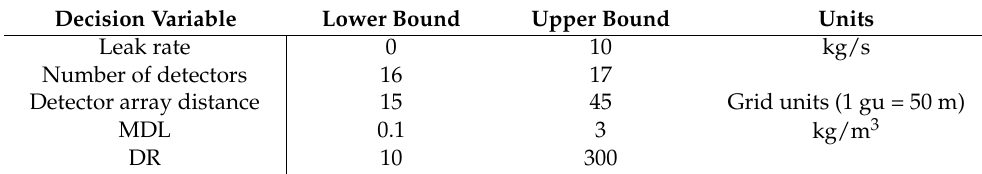
Table 1. Upper and lower bounds of the decision variables.